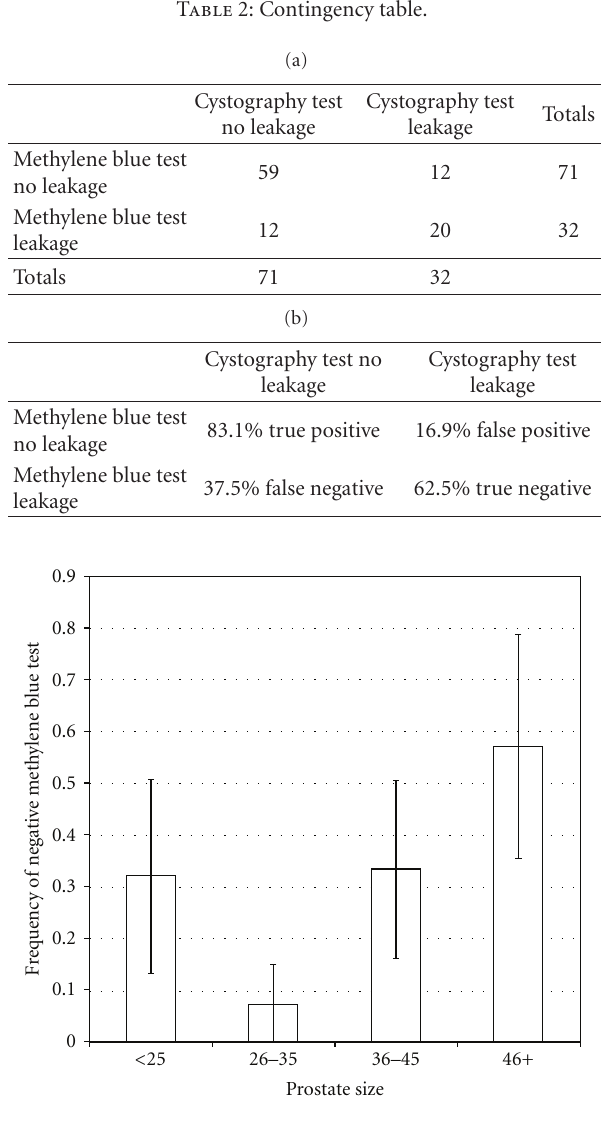
Figure 1: Relationship between prostate size and negative IMBT (i.e., no